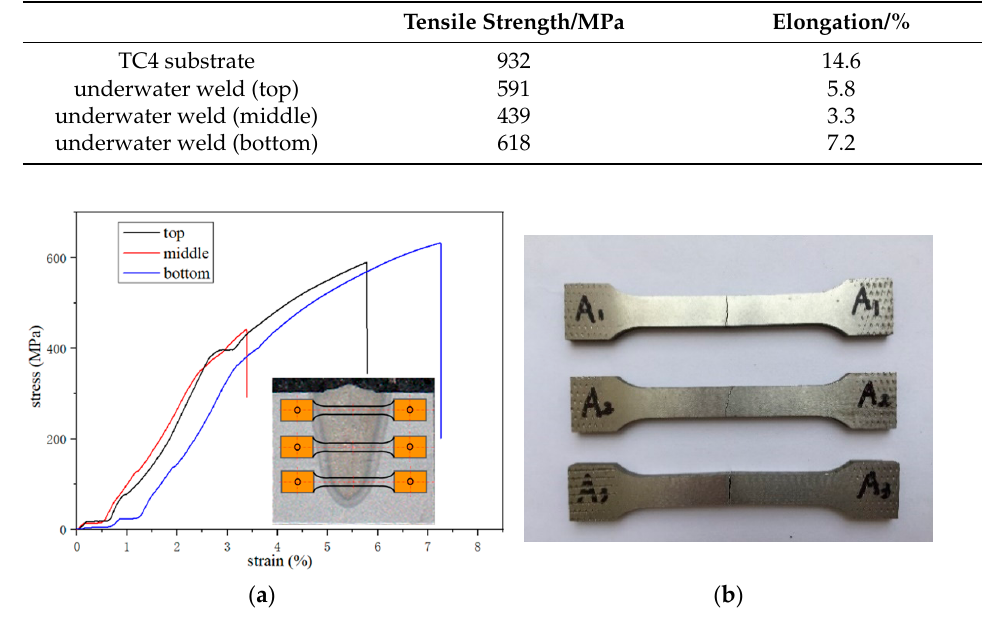
Figure 15. Tensile test: ( a ) stress-strain curves; ( b ) tensile specimens.